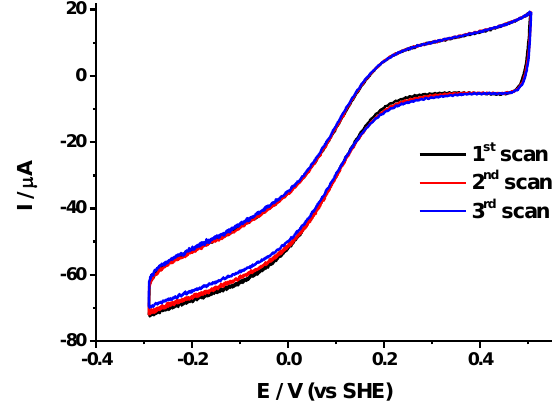
Figure 4. Three consecutive voltammograms obtained for cytochrome bd oxidase covalently immobilized on gold NPs modified with Ni-NTA self-assembled monolayers (SAMs).